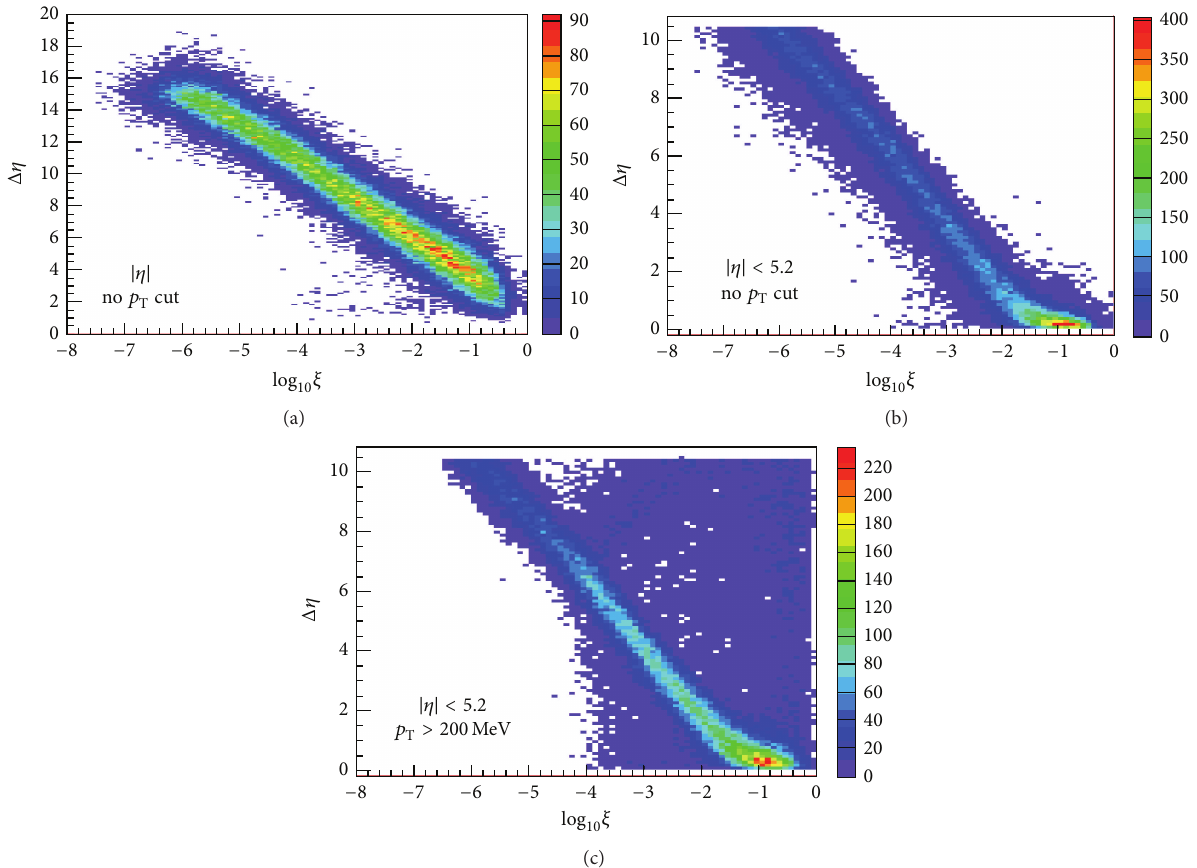
Figure 3: The relation between the size of the large rapidity gap, Δ𝜂 , and log 10 𝜉 for SDD events. The gap is defined as an edge gap. (a) Whole pseudorapidity range is used without any transverse momentum ( 𝑝 T ) threshold on particles. (b) For particles within |𝜂| < 5.2 without any 𝑝 T threshold. (c) For particles within |𝜂| < 5.2 with 𝑝 T > 200 MeV.